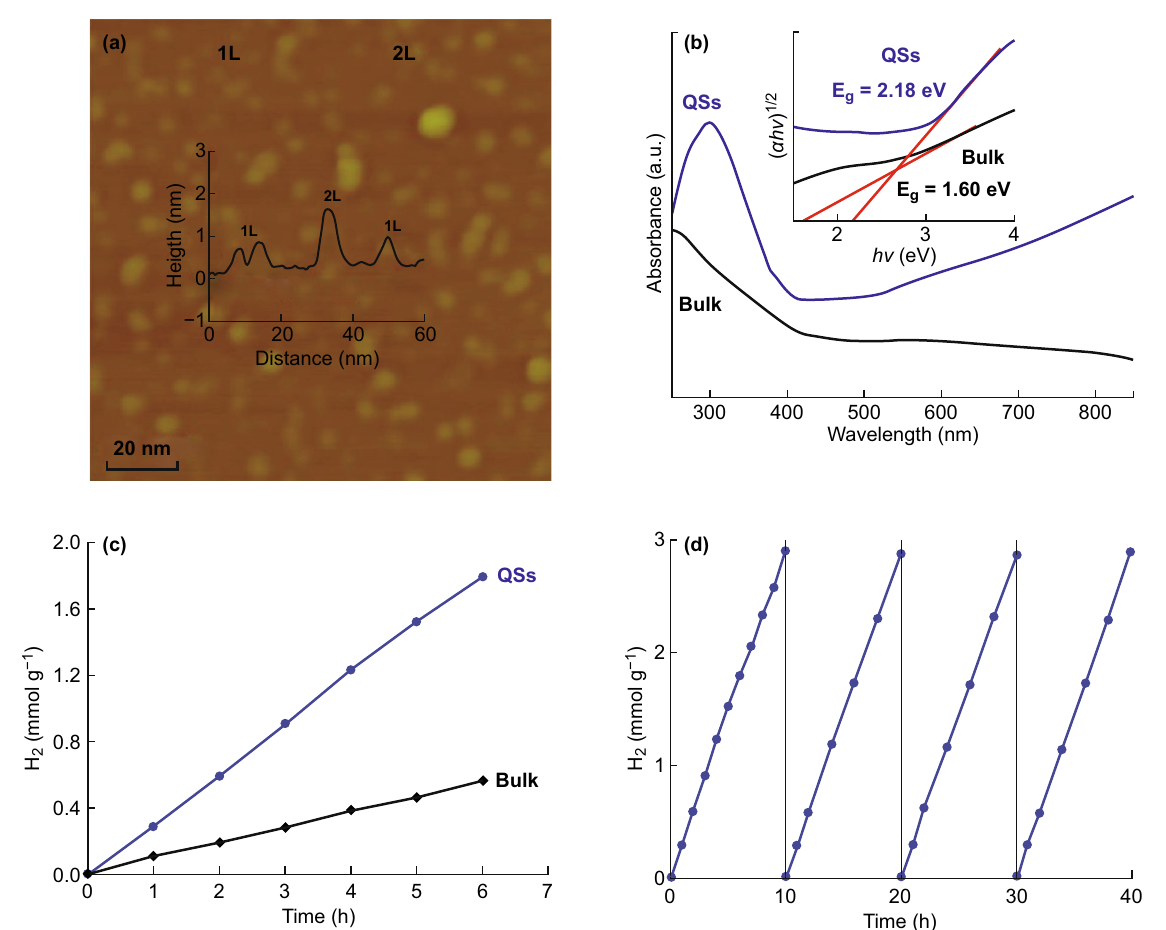
Fig. 4 a AFM images and corresponding height analysis of FePS 3 quantum sheets. b UV–Vis/NIR diffuse reflectance absorption spectra and estimated bandgap potential (inset) of synthesized FePS 3 bulk (1.60 eV) and quantum sheets (2.18 eV). c Plots of hydrogen production through direct photocatalytic water splitting of the FePS 3 bulk and quantum sheets in 100 mL deionized water with 10% TEOA as sacrificial agent. d Cycling measurements of hydrogen gas evolution with FePS 3 quantum sheets [63]. Reproduced with permission. Copyright (2018), Wiley– VCH, GmbH & Co.